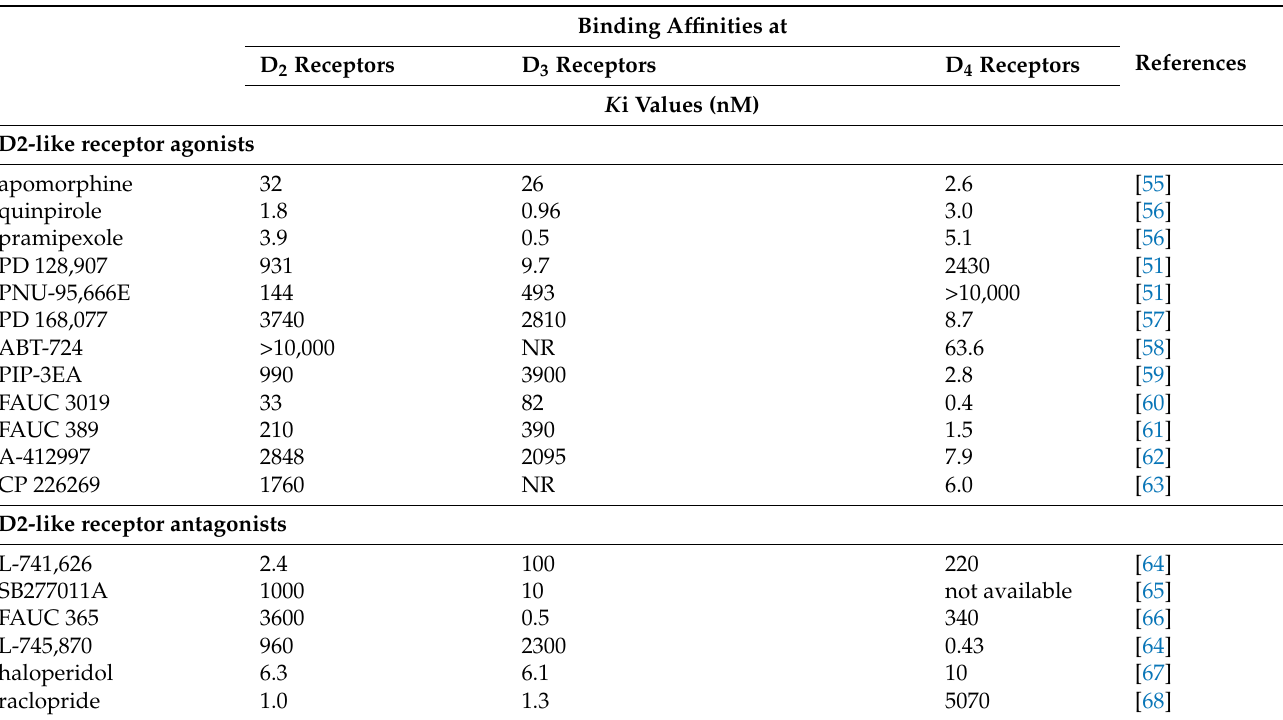
Table 3. Binding affinity characterization of D2-like receptor agonists and antagonists by in vitro studies on the D 2 , D 3 and D 4